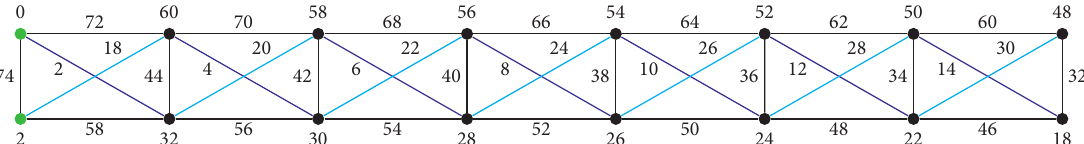
Figure 14: A 2-edge even graceful for the diagonal ladder DL